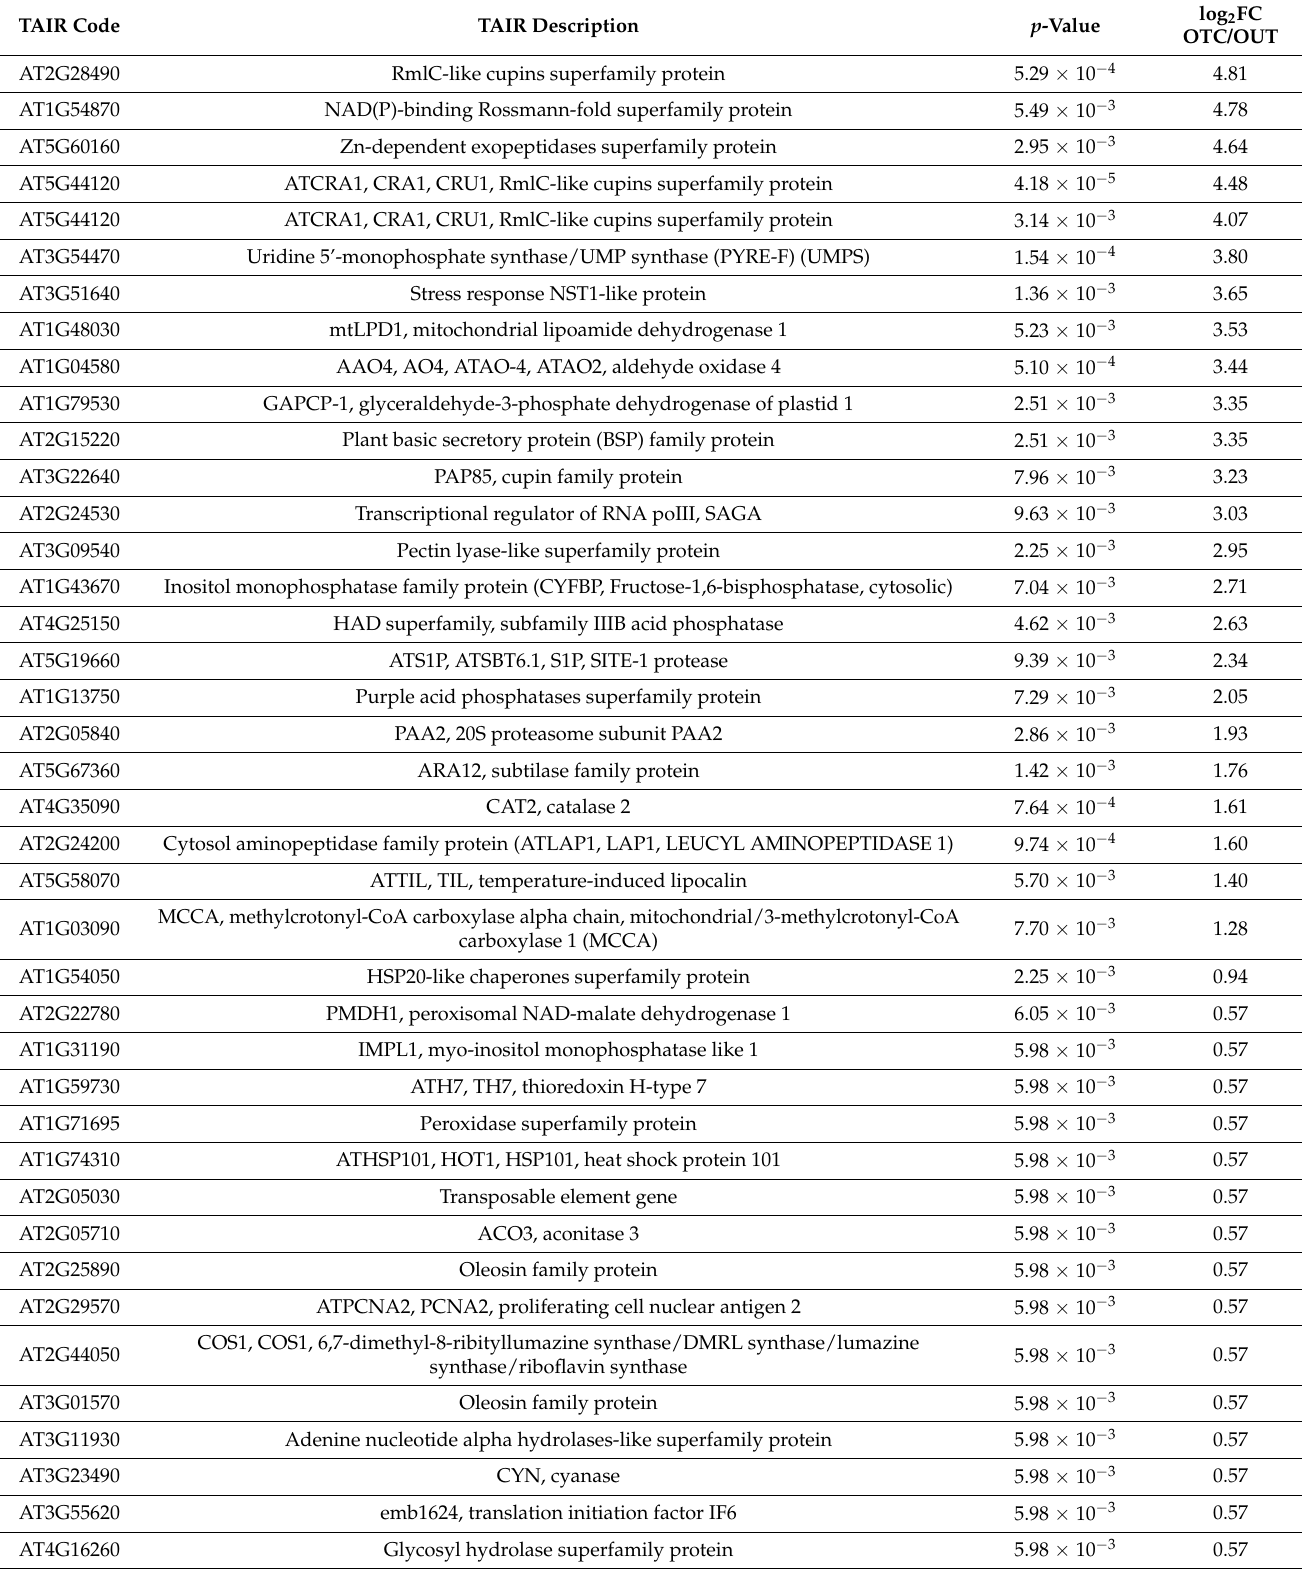
Table 1. List of the 41 upregulated